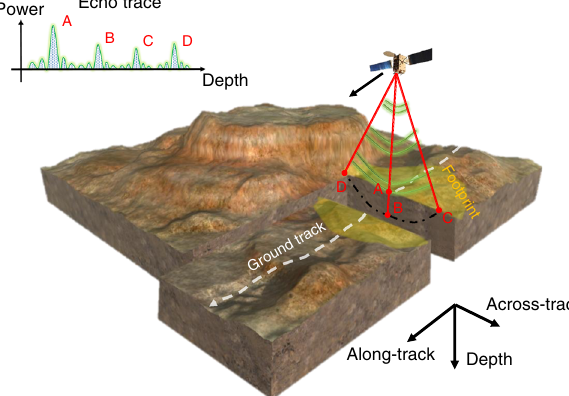
Fig. 1 Radar sounding acquisition geometry. The radar sounding main goal is to acquire the signal coming from the nadir surface and subsurface regions (points A and B). Due to the large antenna footprint, the echo trace contains unwanted re fl ections coming from the antenna footprint sides (points C and D). A radar sensor measures time intervals occurring between the signal transmission and reception and not absolute distances. This implies that re fl ections from points C and D can be disguised as subsurface signal. In fact, in a radar system distance is inferred from time delay by knowing the wave speed in the